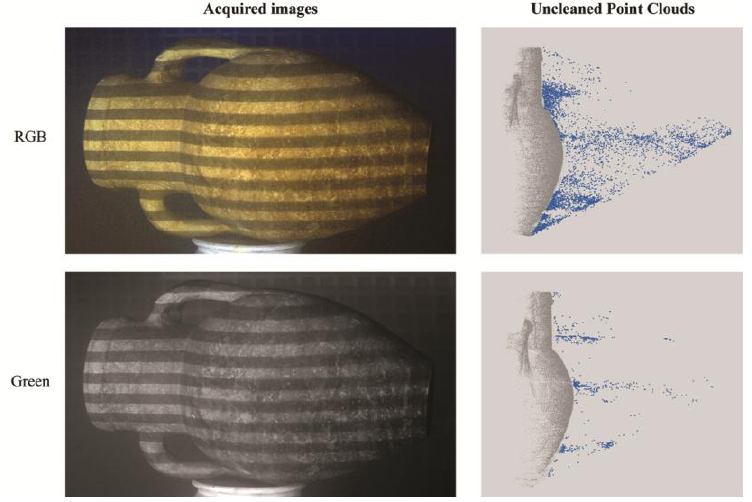
Figure 11. Acquired images and unclean point clouds at a light turbidity level (T1) in each colour channel: the blue points are due to scattering effects, which are highly reduced in the green channel.